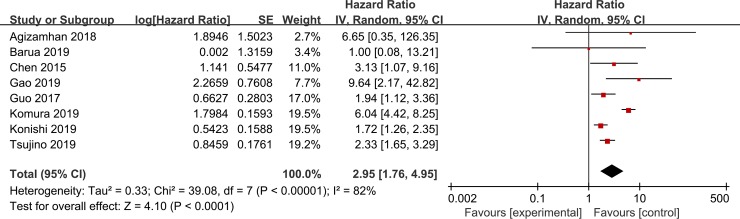
Forest plots of the correlation between CAR and OS in RCC patients.